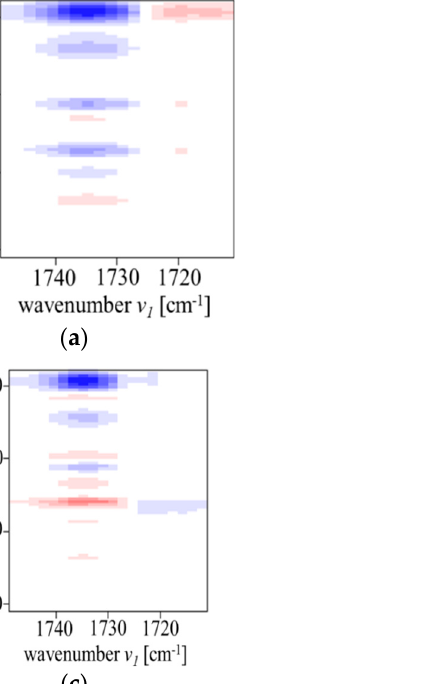
negative correlation intensities, respectively. correlation intensities,